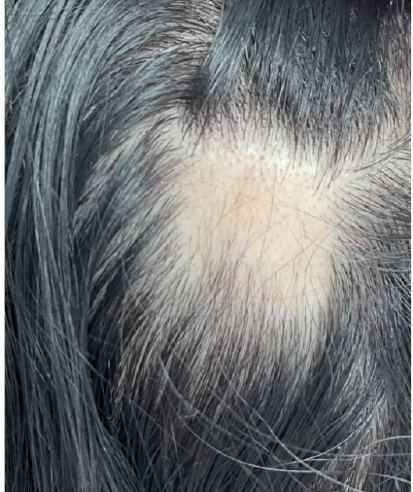
Figure 1. Patchy alopecia areata: a single, round-oval plaque with a diameter of approximately 4 cm, showing hair loss. This is a 54-year-old female patient diagnosed with Hashimoto’s thyroiditis (after alopecia onset) with normal thyroid function (TSH of 1 µUI/mL, normal between 0.5 and 4.5 µUI/mL, high TG-Ab of 129 UI/mL, normal <4.11 UI/mL, and normal serum TPO-Ab of 3 UI/mL, normal <5.6 UI/mL).